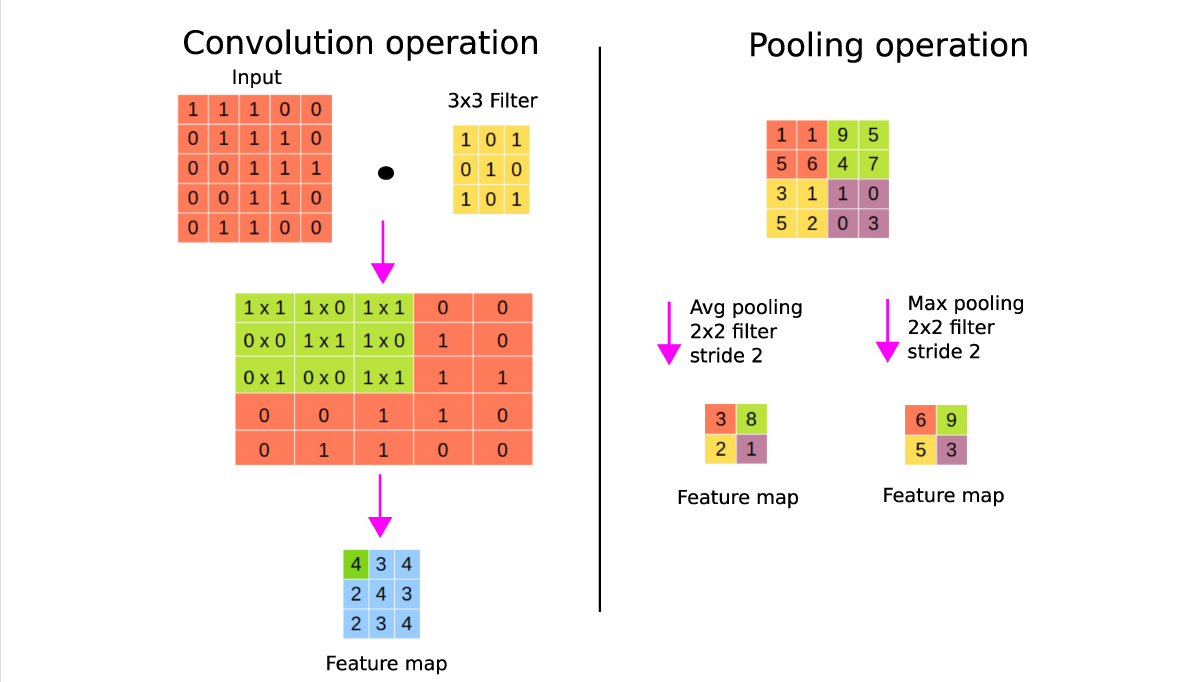
FIGURE 5 CNN ’ s fundamental operations. On the left panel, a convolution operation is shown where the sum of the element-wise multiplications using a fi lter across the input data is performed to generate a feature map. On the right panel, average and maximum pooling operations are